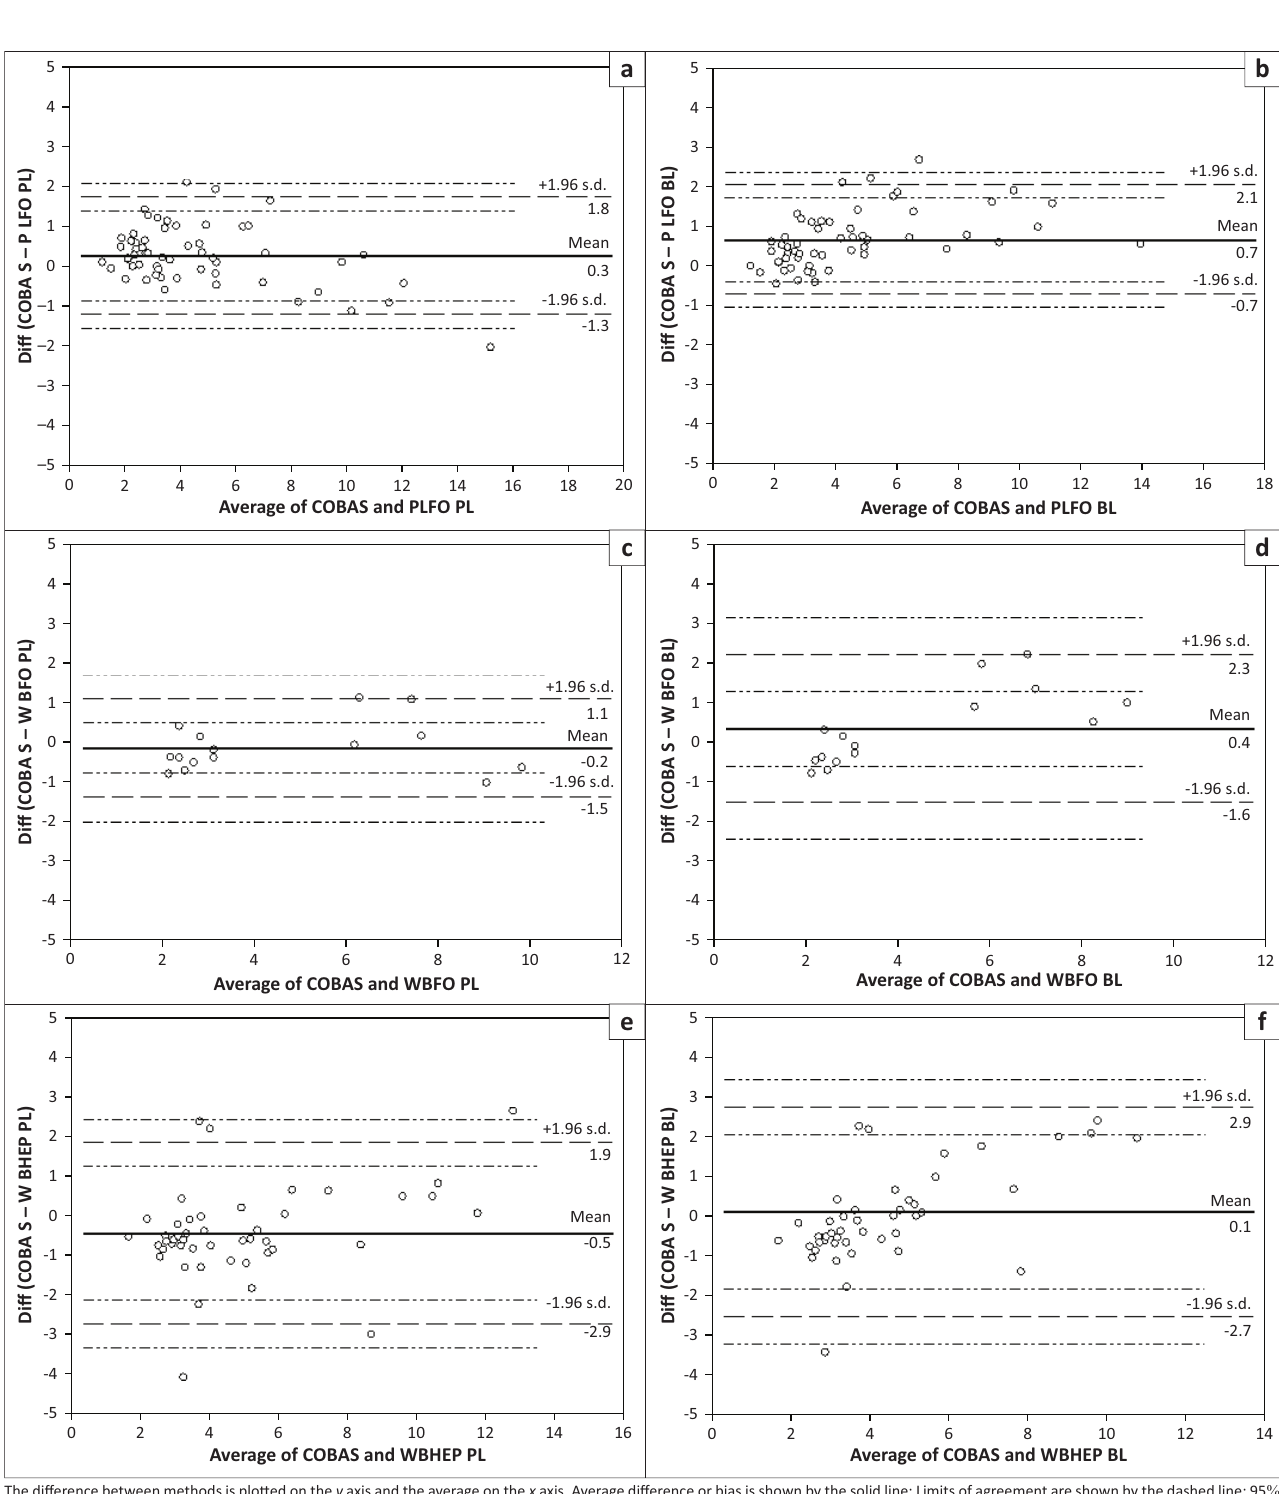
The difference between methods is plotted on the y axis and the average on the x axis. Average difference or bias is shown by the solid line; Limits of agreement are shown by the dashed line; 95 % CI for the limits of agreement are shown by the broken dash and dot line. COBAS, plasma lactate measured with the laboratory method; PFO PL, plasma in fluoride oxalate, Accutrend in PL mode; PFO BL, plasma in fluoride oxalate, Accutrend in BL mode; WBFO PL, whole blood in fluoride oxalate, Accutrend in PL mode; WBFO BL, whole blood in fluoride oxalate, Accutrend in BL mode; WBHEP PL, whole blood in heparin, Accutrend in PL mode; WBHEP BL, whole blood in heparin, Accutrend in BL mode; LOA, limits of agreement; BL, blood; PL, plasma. FIGURE 1: Bland – Altman plots of rhino blood lactate concentration. The plots describe agreement between plasma lactate measured with a laboratory method (COBAS) and the Accutrend handheld meter. Lactate is measured on the Accutrend with different sample types using either the blood or plasma mode. (a) Plasma in fluoride/ oxalate, plasma mode, (b) plasma in fluoride/oxalate, blood mode, (c) whole blood in fluoride/oxalate, plasma mode, (d) whole blood in fluoride/oxalate, blood mode, (e) whole blood in heparin, plasma mode and (f) whole blood in heparin, blood